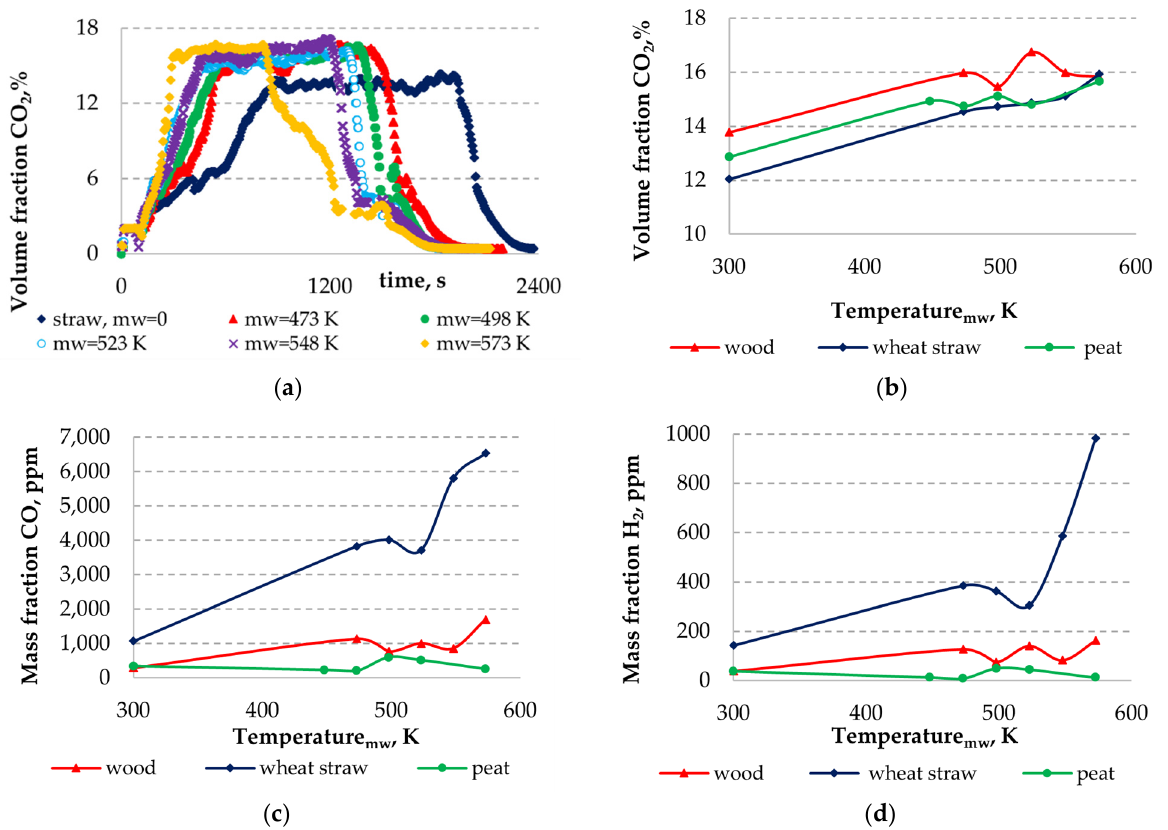
Figure 10. The effect of mw pretreatment on kinetics of the formation of CO 2 emission ( a ) and the average values of CO 2 ( b ), CO (c) and H 2 ( d ) in the products.